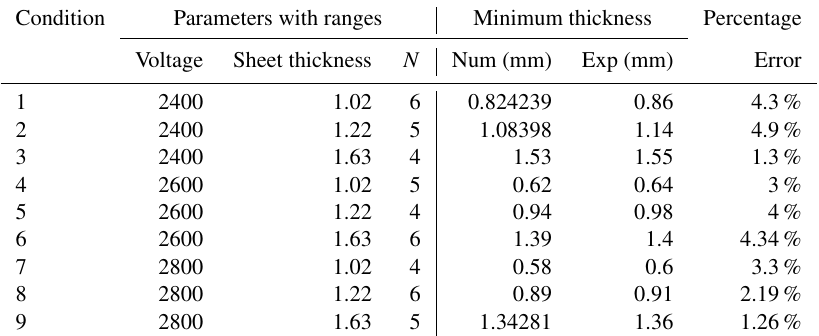
Table 4. Minimum thickness numerical and experimental results. Condition